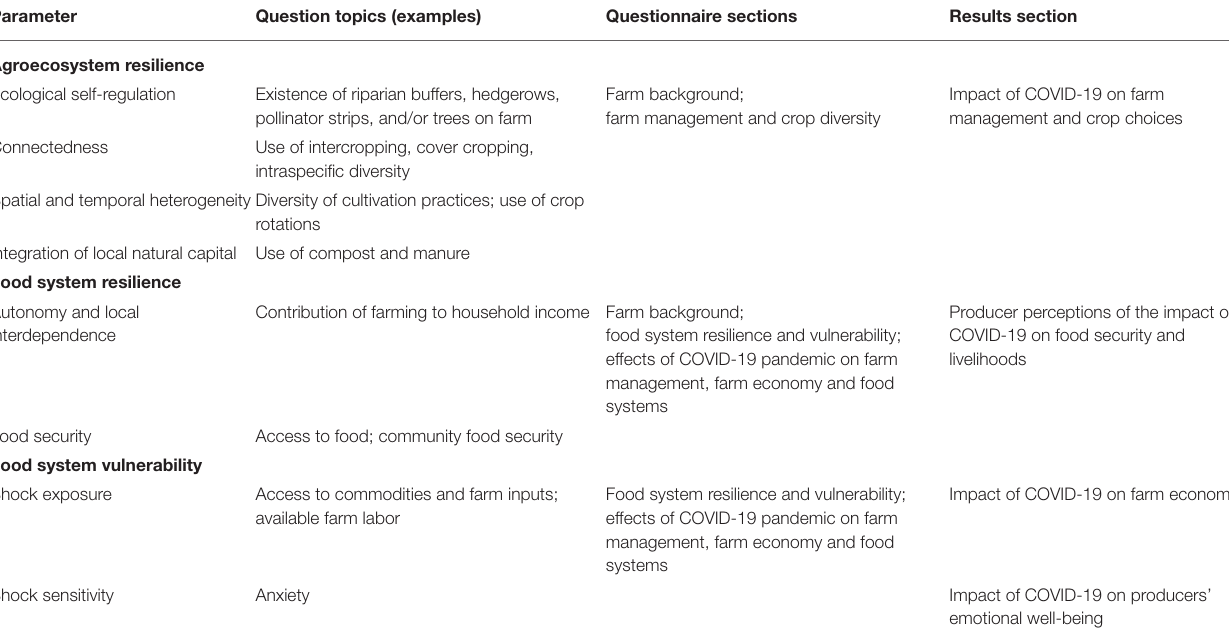
TABLE 1 | Food systems resilience and vulnerability